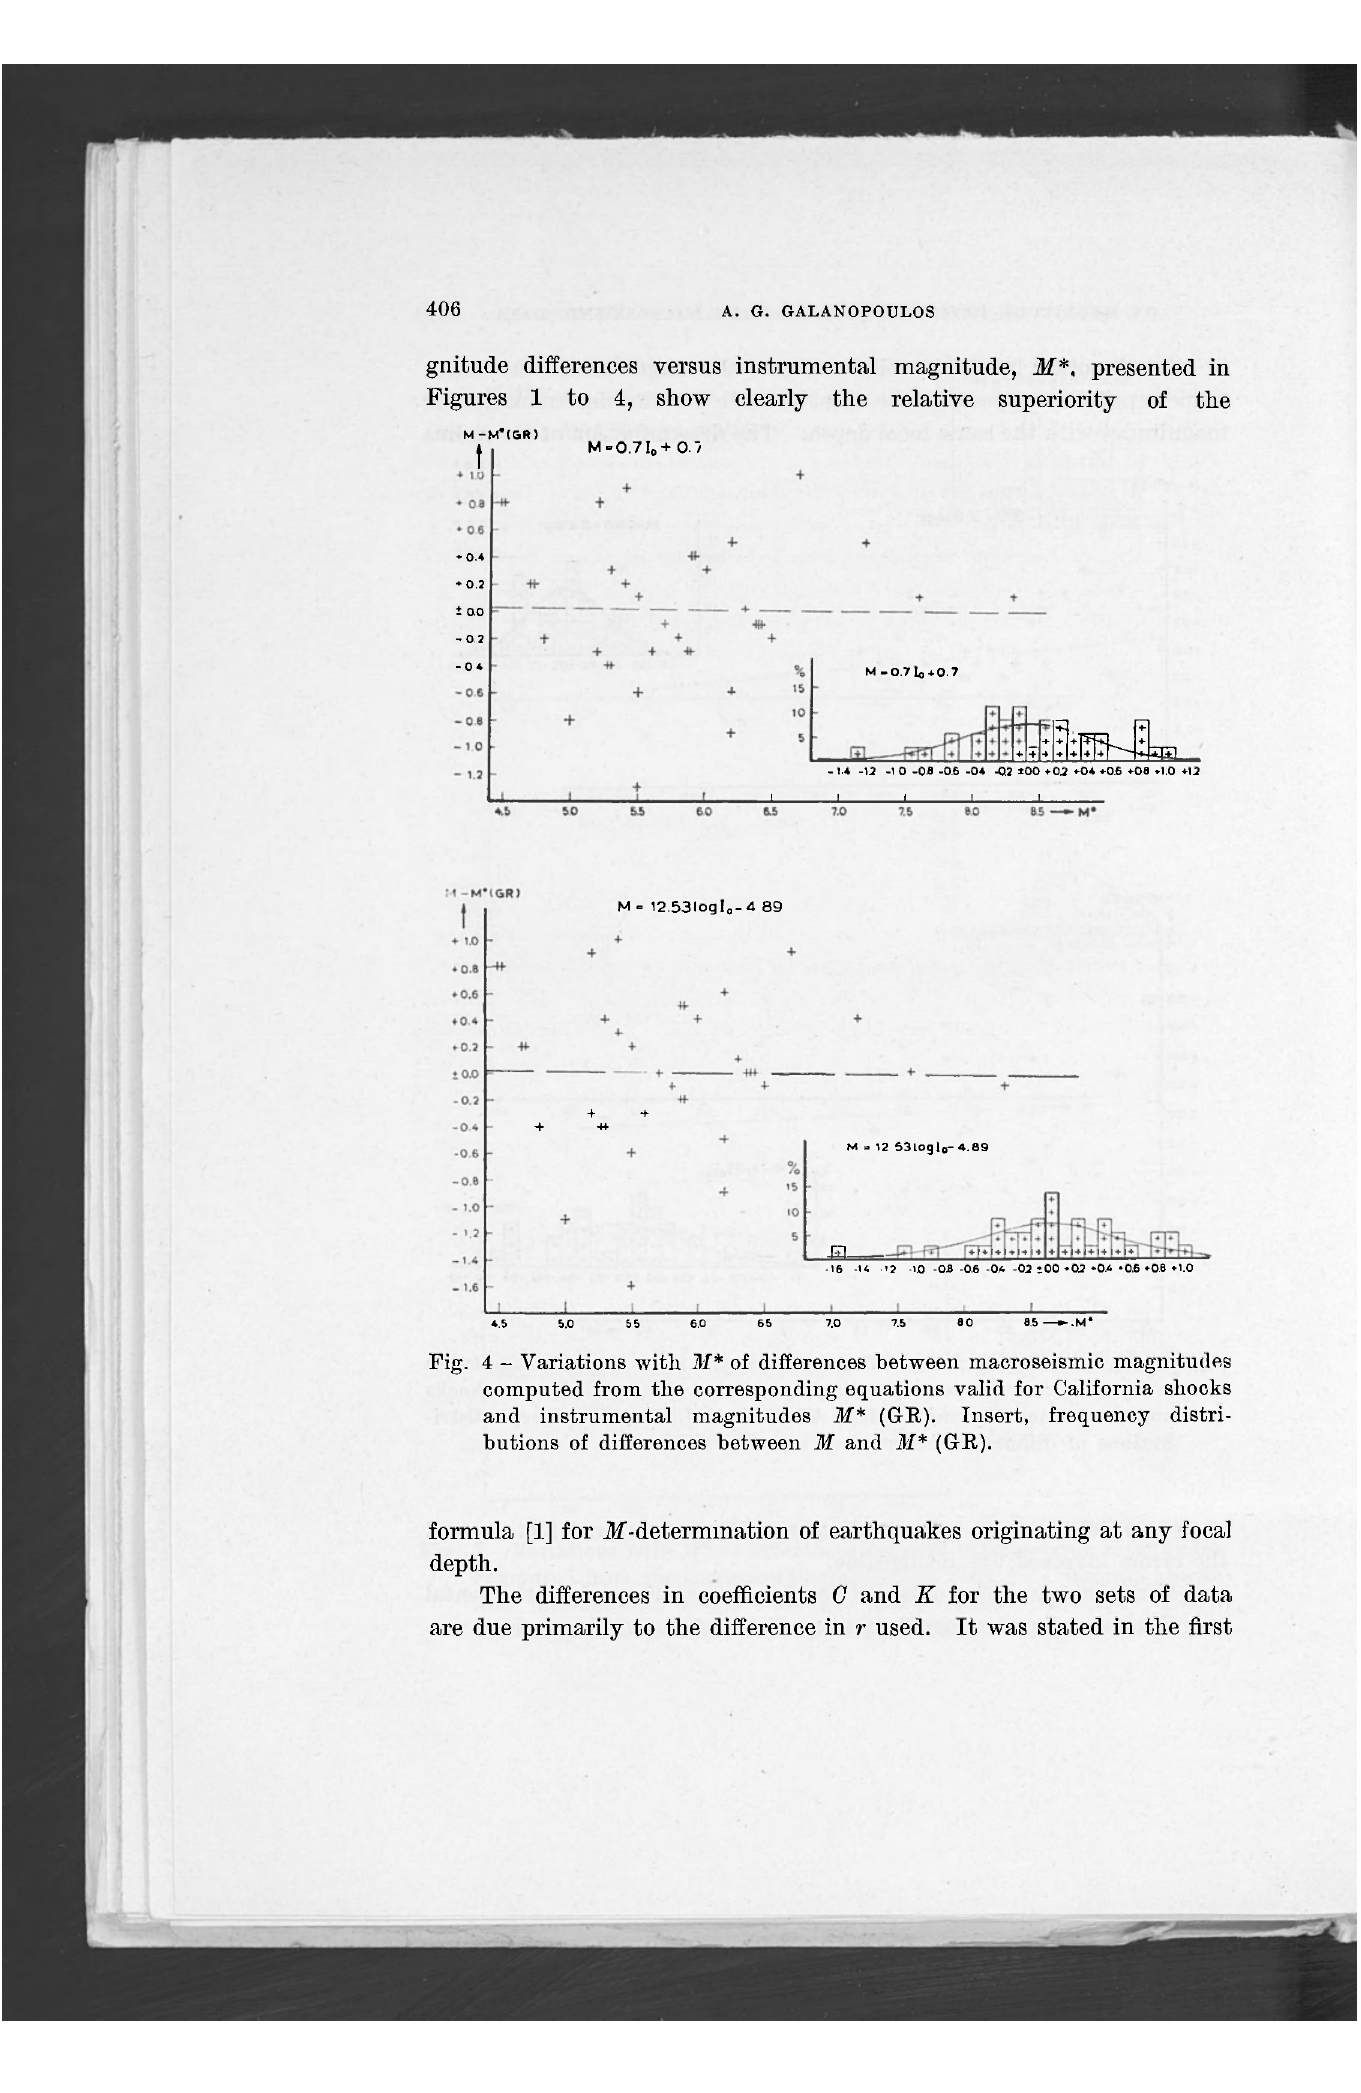
formula [1] for Jlf-determmation of earthquakes originating at any focal